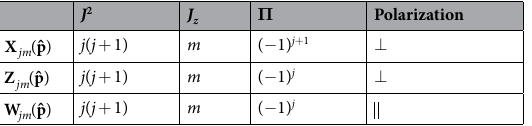
Multipolar coupling between sources and fields in momentum space. The decomposition in Eq. (2) is useful for discussing the physics of multipolar couplings between the sources and the fields. The complex scalars ω ω a b { , } determine the coupling of the source to the transverse electromagnetic field, a.k.a radiation field, a.k.a jm jm coefficients of the source and the electromagnetic waves. The one-to-one relationship between the ω ω a b { , } jm jm multipolar fields of frequency ω radiated by it is exposed in App. B of ref. 26, Chap. 9.10 in ref. 27, and ref. 23, for example, where the analysis is made in the r domain. The ω ω a b { , } represent independent degrees of freedom in jm jm the following sense. Each individual coefficient is connected to the radiation (absorption) of a particular kind of electromagnetic wave: A transverse multipolar field with well defined frequency, angular momentum, and parity. The ω a are connected to the multipolar waves of electric parity and the ω b to those of magnetic parity (see jm jm Table 1). The multipolar waves connected to different coefficients are orthogonal to each other. In principle, each individual ω ω a b { , } can be independently measured through the interaction of the source with the radiation field. jm jm represent the longitudinal degrees of freedom of ω ˆ J p ( ) , but the longitudinal electric field with | p | = ω / c The ω c jm is zero outside the source region defined in Fig. 1. This can be explained in the following way. The longitudinal components of the current ( ω c ) generate a longitudinal electric field outside the source region defined in Fig. 1, jm